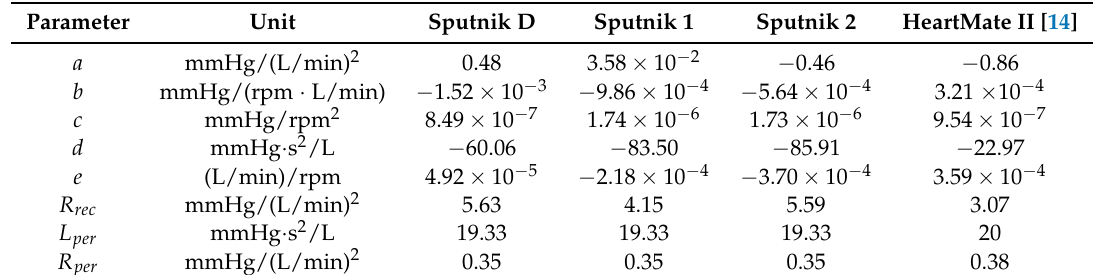
Table 2. Parameters of model (4).